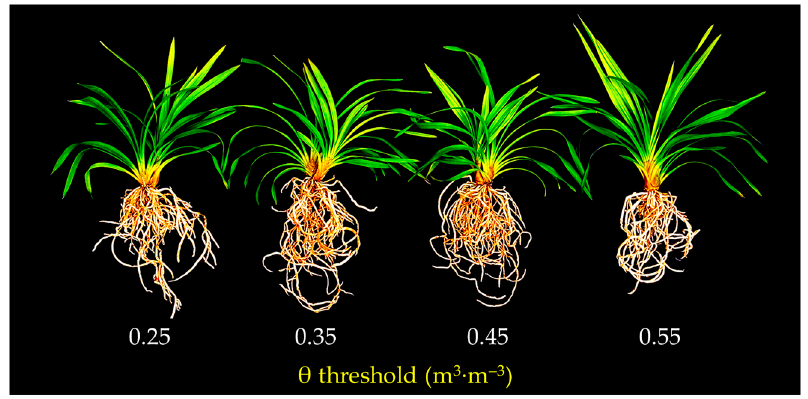
z Primary pseudobulb was the first formed pseudobulb after deflasking. y Mean separation among the θ threshold treat- ments followed analysis of variance (ANOVA) with Duncan’s multiple range test at α = 0.05 .